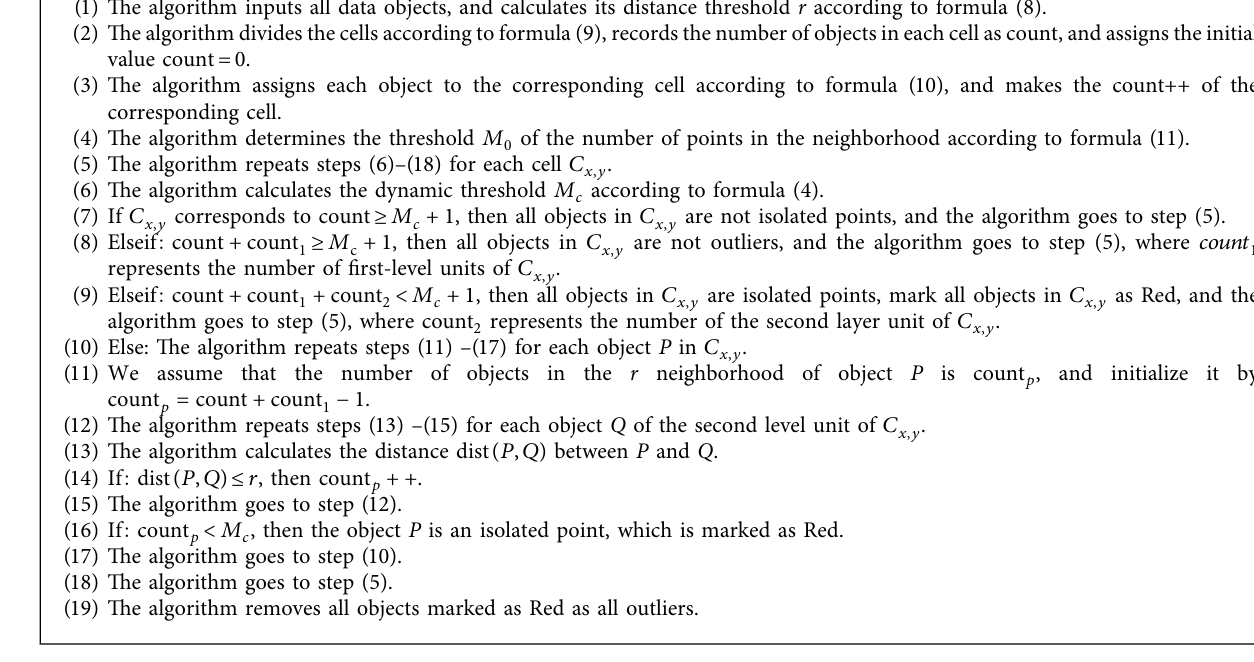
A LGORITHM 1: Cell-based outlier detection algorithm flow.